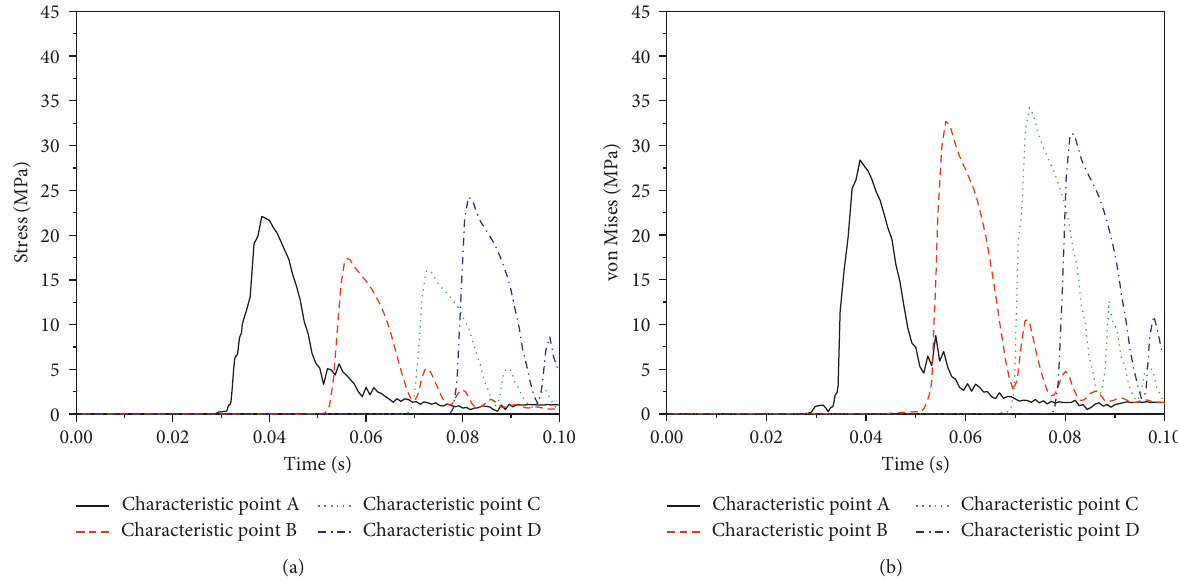
Figure 9: Stress curves of the characteristic points. (a) Circumferential stress. (b) Von Mises